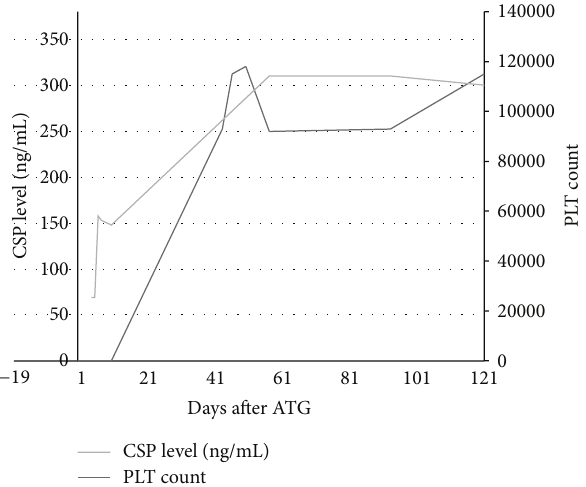
Figure 2: Patient’s platelet counts over 121 days following treatment with ATG and CSP. Displayed in dark and light grey lines are platelets count and CSP levels,